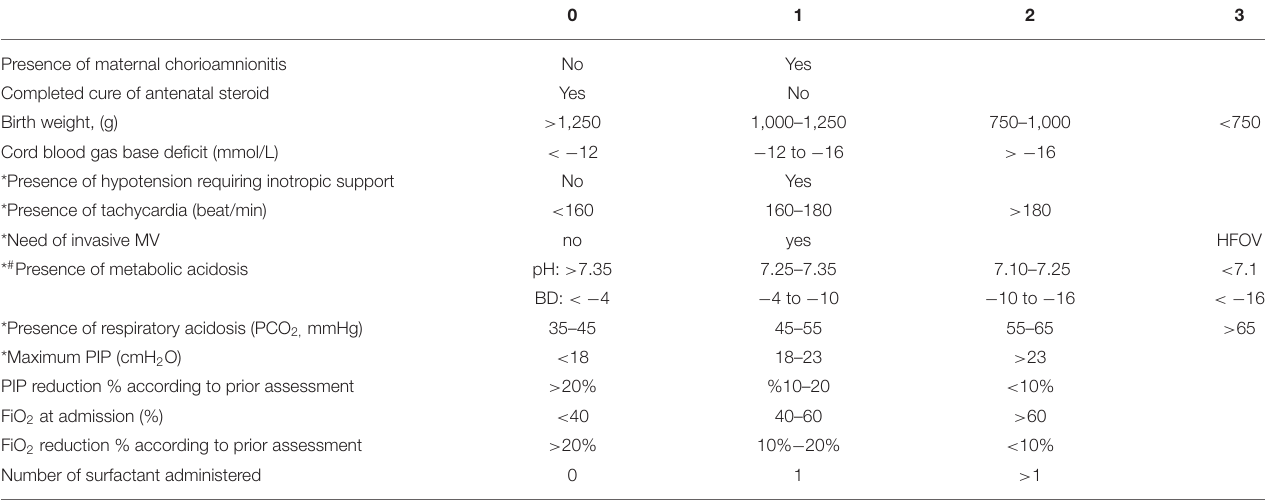
TABLE 1 | Criteria of SIMPLE scoring system.